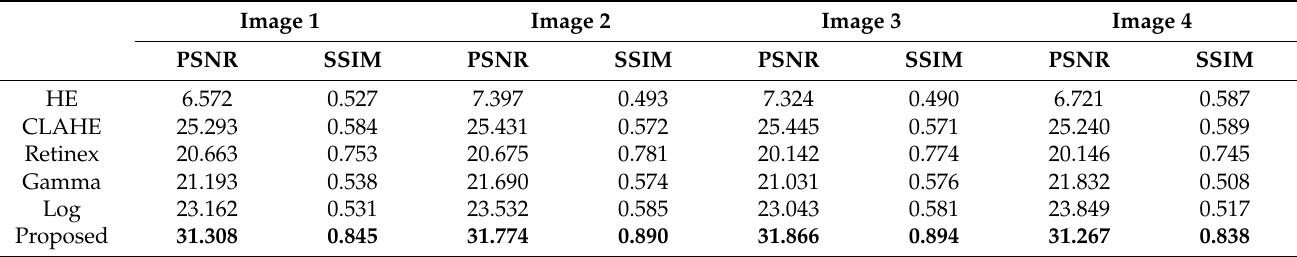
Table 1. Numerical results on synthesized images. The highest scores are marked in